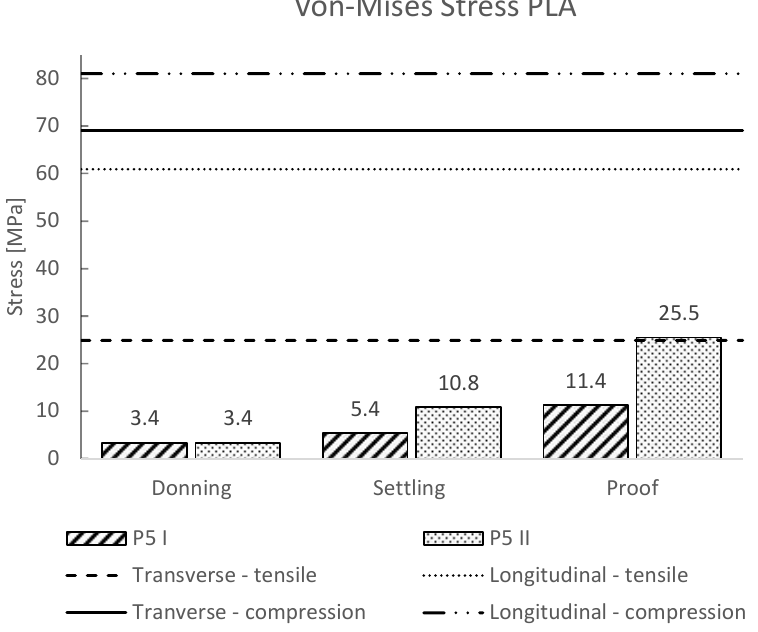
Figure 4. Von-Mises stress of the 3D-printed PLA socket for the loading cases P5 I and P5 II. Addi- tionally, the transverse and longitudinal yield stresses are shown with horizontal dashed lines.